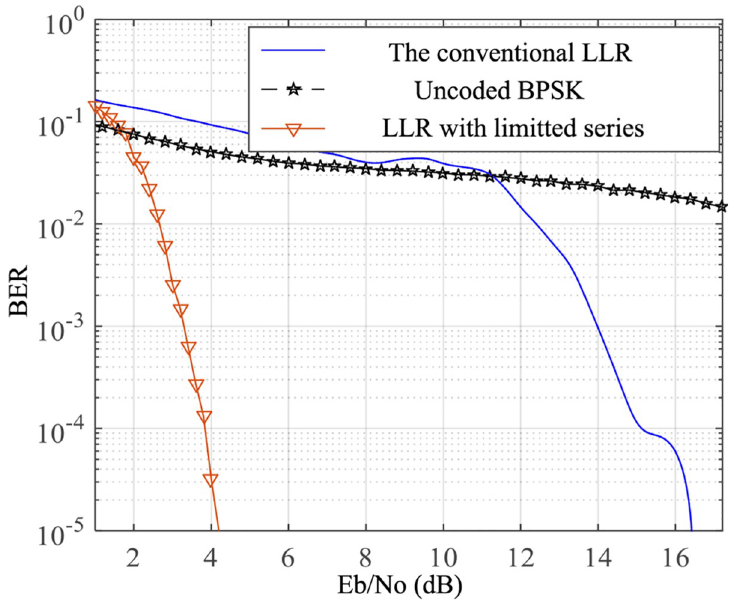
Fig 5. BER performance of the optimized FFT BP algorithm on AWAN channel.